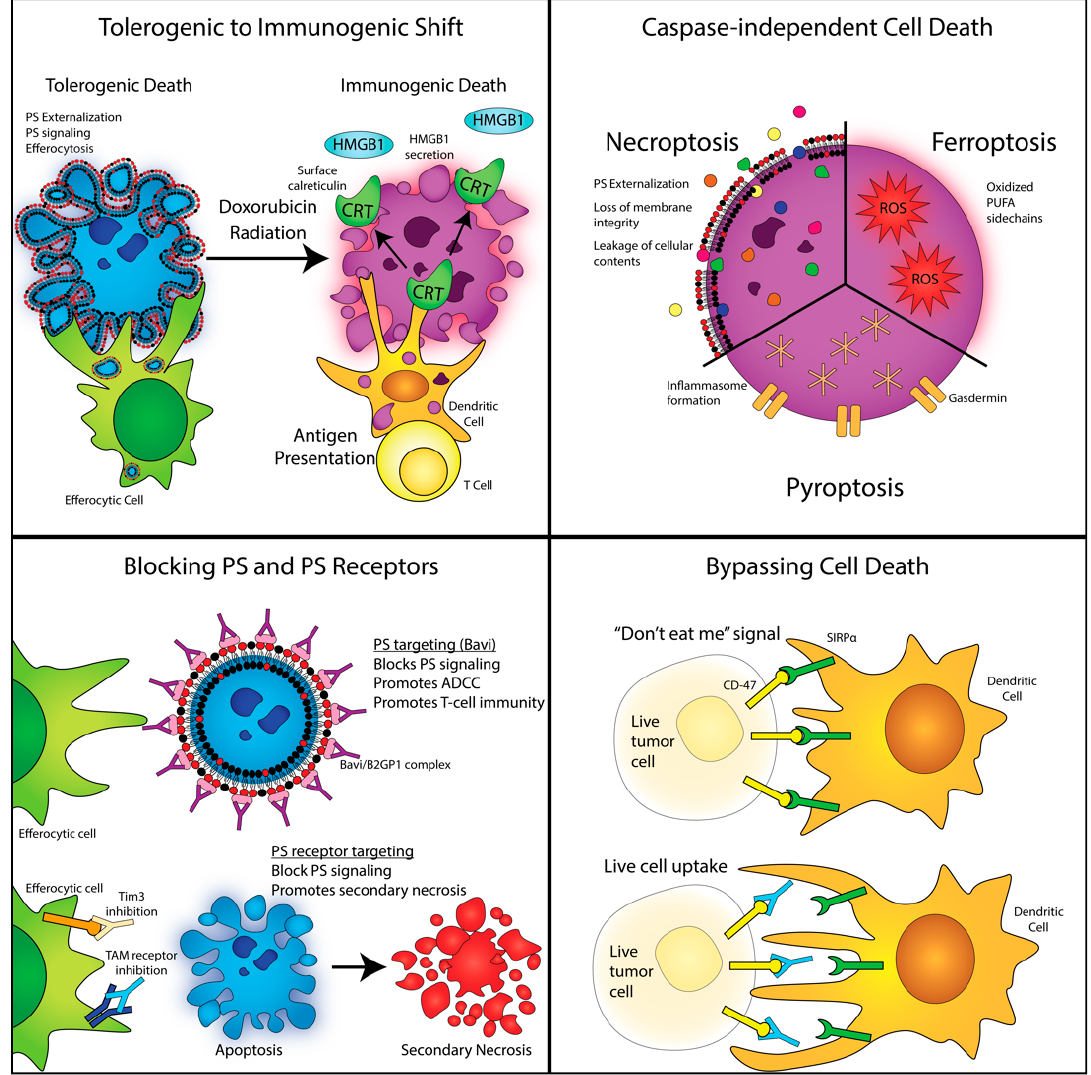
Figure 2. Targeting apoptotic and efferocytic pathways in cancer immunology . Top left: Tolerogenic to immunogenic shift. Shifting to an immunogenic cell death via chemotherapy and radiation therapy promotes the influx of antigen-presenting cells, whereby T cells can become educated against the tumor. Top right: Caspase-independent cell death. Caspase-independent cell death promotes immunogenicity via multiple mechanisms. Though phosphatidylserine (PS) is externalized on necroptotic cells, the loss of membrane integrity and release of intracellular contents “override” any immunosuppressive signaling. Ferroptosis and pyroptosis promote an inflammatory response by either oxidation or the formation of gasdermin pores, respectively. Bottom left: Blocking PS and PS receptors. Blocking PS signaling, either by targeting PS directly or PS receptors, prevents efferocytosis and leads to secondary necrosis, promoting an inflammatory response. Bottom right: Bypassing cell death. Targeting CD-47/SIRPa, the “don’t-eat-me” signal, permits the uptake of live tumor cells. Note: HMGB1—high mobility